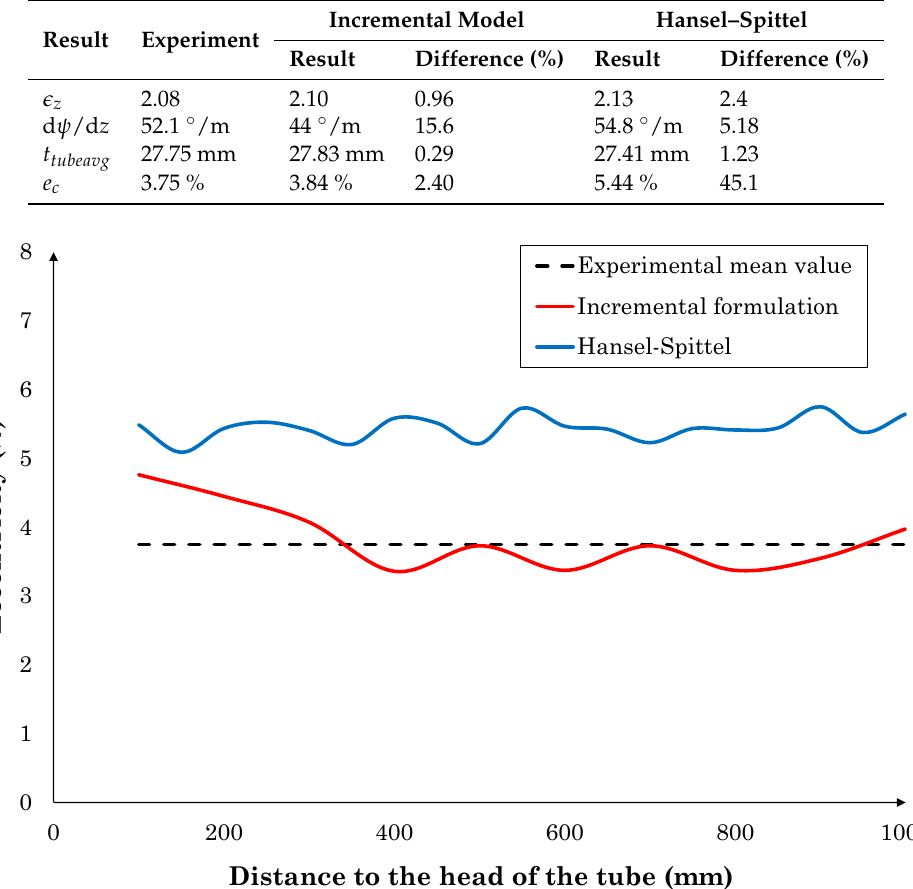
Figure 2. Numerical and mean experimental results of wall thickness